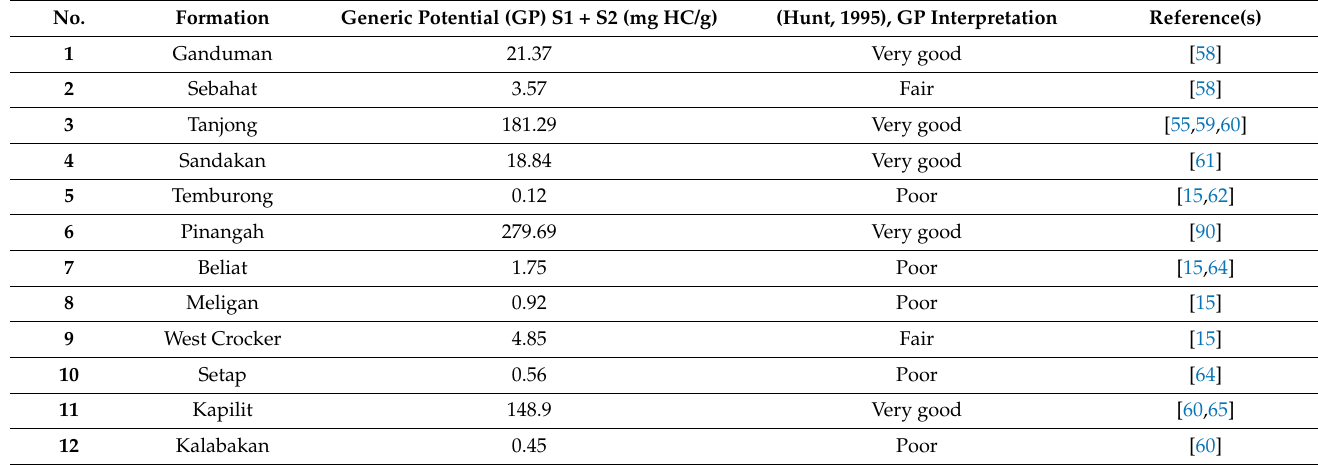
Table 12. Interpretation of average GP values of formations in Sabah according to Hunt